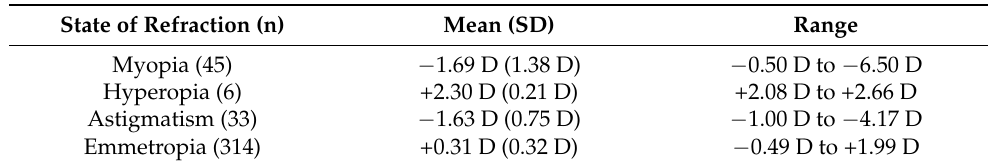
Table 1. The number of children with different cycloplegic refractive errors, the mean refractive error in each group, and the range of refraction in the right eye.